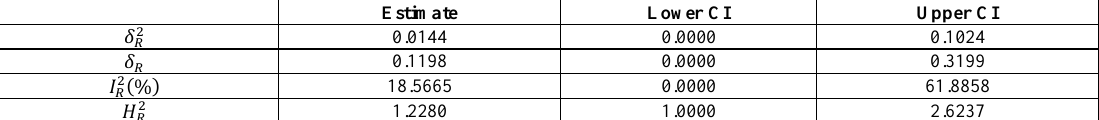
Table 4. Estimates of heterogeneity and variability for random effects model